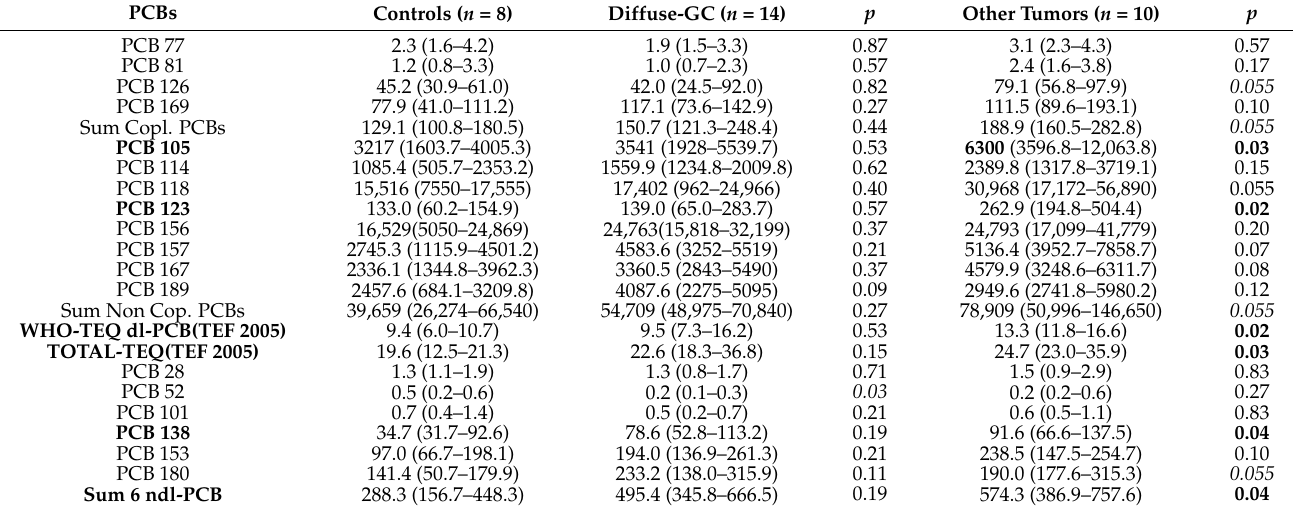
Table 3. Summary of polychlorobiphenyls (PCBs) distributions and detection frequencies (DF) measured in omental fat from cases of diffuse-gastric cancer, other cancers with peritoneal metastasis, and non-cancer as control patients. Results were represented by median (interquartile range) (pg/g lipid). The case groups were compared to the control group using Mann–Whitney U test ( p <